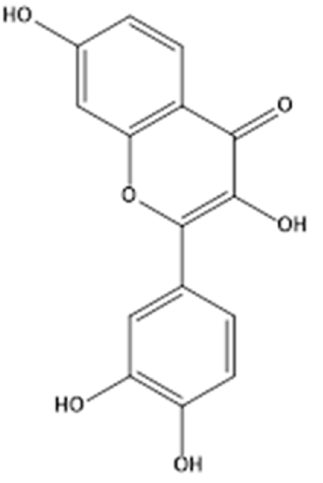
Figure 1. Molecular structure of fisetin.